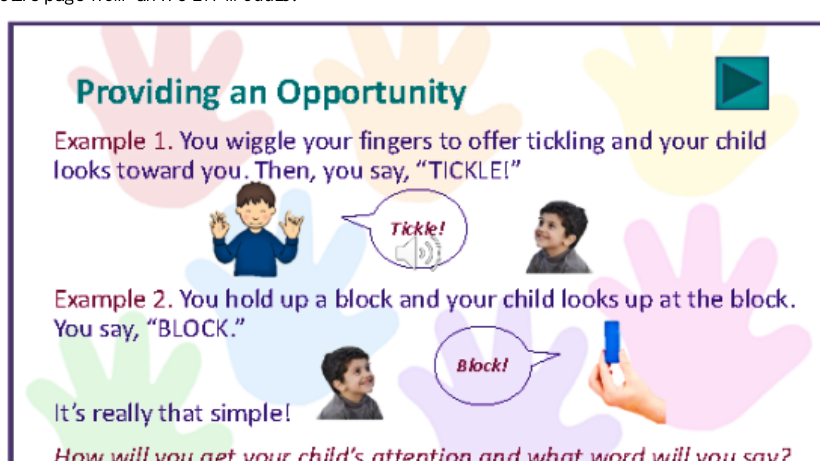
Figure 2. Example interactive page from an HOLA